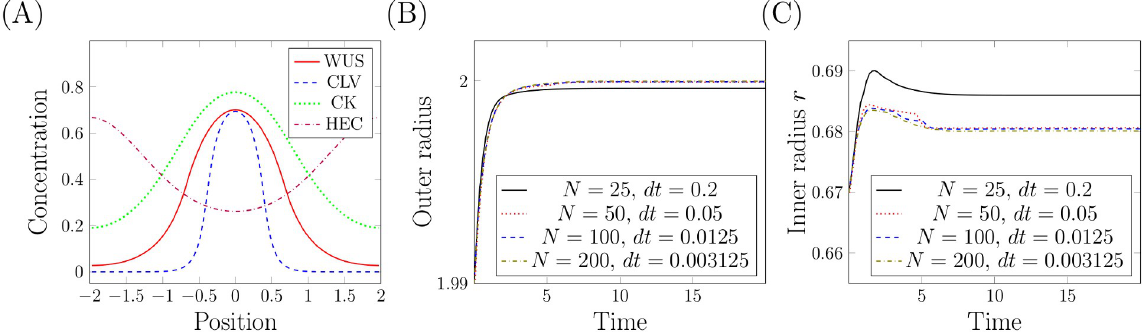
Fig 4. Numerical calculation of the steady-state. (A) For the depicted initial condition the system approaches the equilibrium depicted in Fig 3 (A). The corresponding evolution of R and r is depicted in (B) and (C) respectively. Calculations have been performed for different mesh sizes N and time steps 4 t : N = 25 and 4 t = 0.2 (22704 degrees of freedom), N = 50 and 4 t = 0.05 (90404 df), N = 100 and 4 t = 0.0125 (360804) and N = 200 and 4 t = 0.003125 (1441604